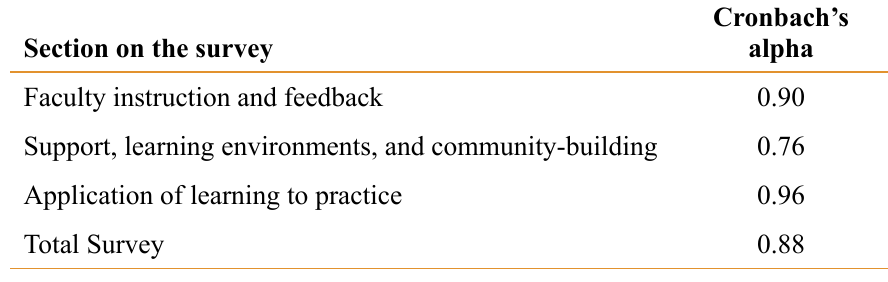
Internal Consistency/Reliability of the